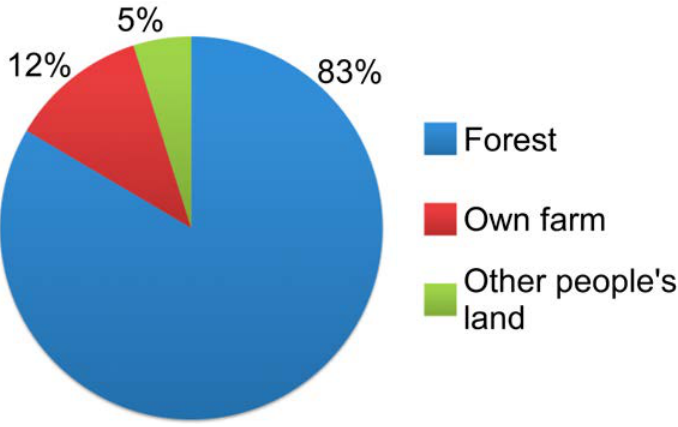
Figure 10. Places for collecting firewood as of 2015, identified during the questionnaire survey ( n = 327).